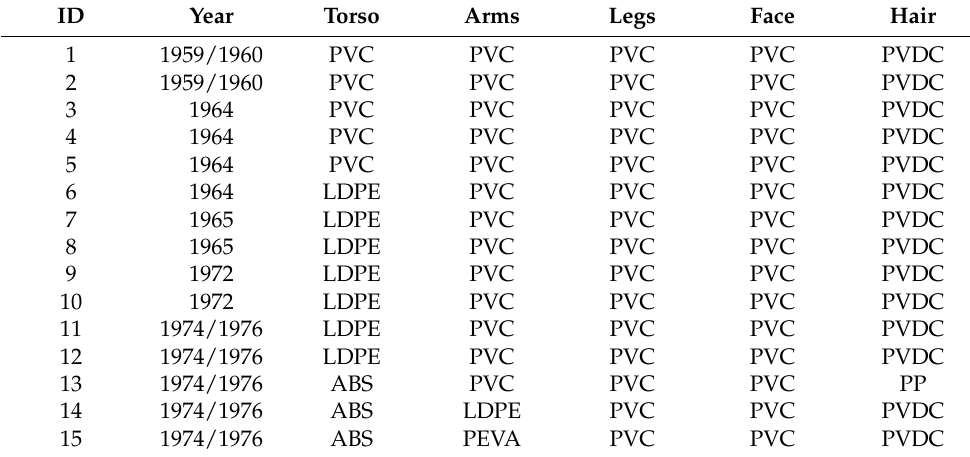
Table 4. Results of the FT-IR ATR analysis, based on the characteristic peaks of the Barbies’ constituent